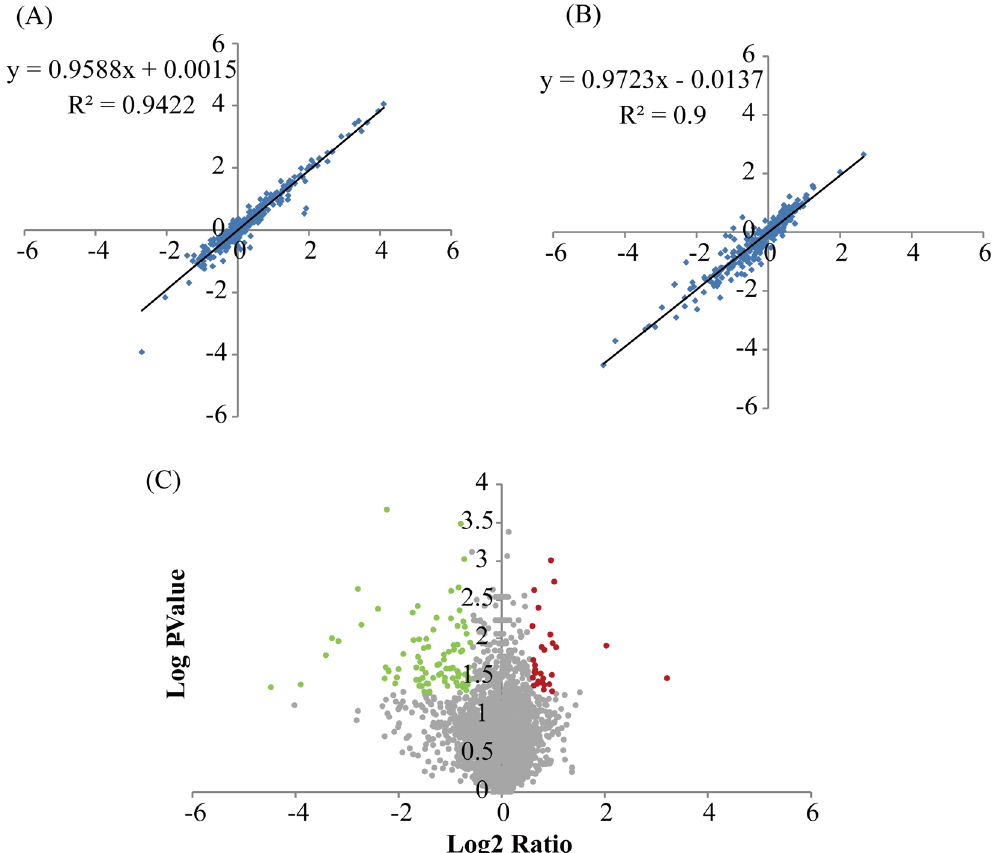
Figure 3. Comparison of log 2 ratios and the volcano plot for the identified proteins from iTRAQ. Log 2 values for the ratios of 114:115 in NT ( A ) and 116:117 ratios in PT ( B ) were used to show good replication in the iTRAQ experiments. The volcano plot shows the collected p-values ( C ) for the changes in the patterns of all identified proteins. Red spots represent up-regulated DEPs; gray spots are unchanged proteins; and green spots are down-regulated DEPs.